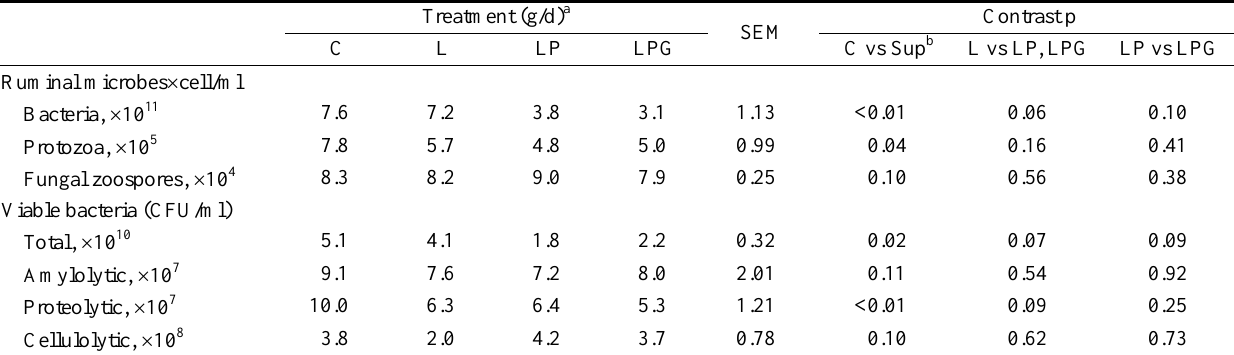
Table 3. Effect of lemongrass, peppermint and garlic supplementation on populations of rumen microbes Treatment (g/d) a